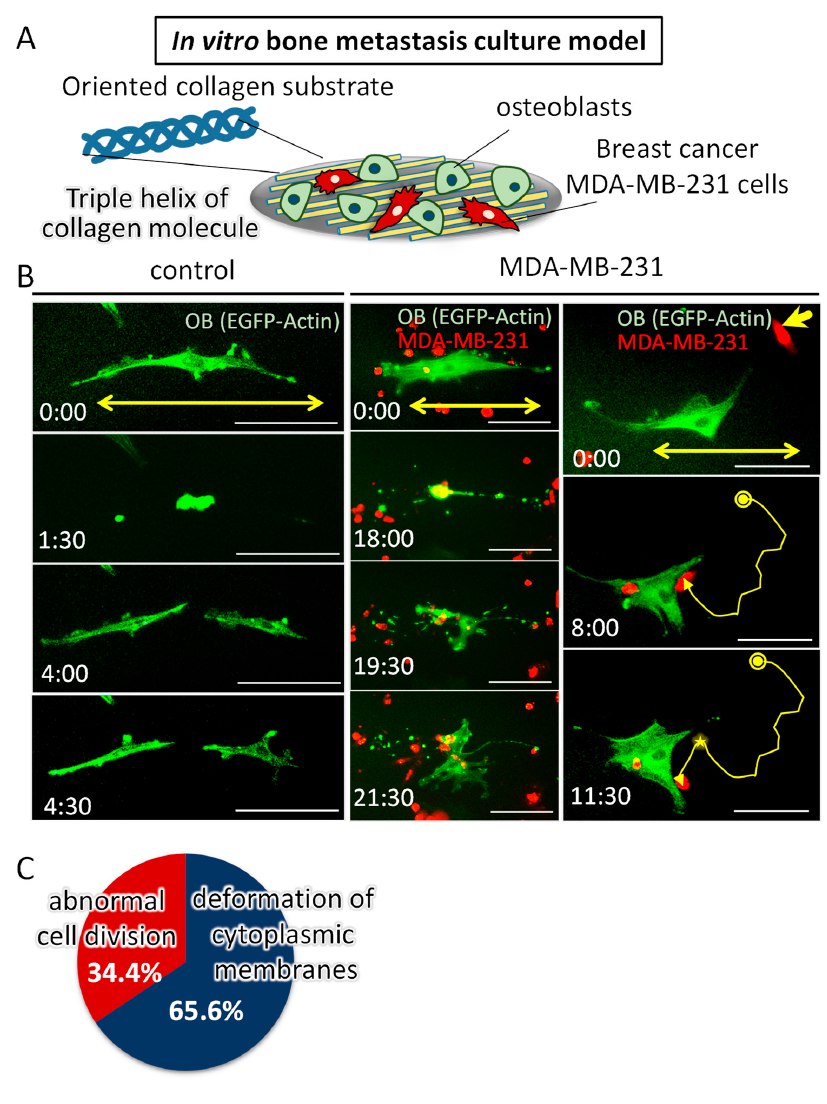
Figure 4. ( A ) Schematic illustration of the in vitro bone metastasis culture model. Osteoblasts and breast cancer MDA-MB-231 cells were cocultured on an artificially controlled oriented collagen substrate. ( B ) Time-lapse imaging of the monocultured osteoblasts (control), and cocultured osteoblasts and MDA-MB-231 cells. Green; EGFP-Actin (osteoblasts), Red; CellTracker (MDA-MB-231 cells). The yellow double-headed arrows indicate the substrate collagen orientation. The yellow arrows with yellow circles indicate the locomotion traces of MDA-MB-231 cells. The yellow circles indicate the initial position of the MDA-MB-231 cell represented by the bold yellow arrow. The star mark indicates the intercellular collision position. Scale bars: 100 µm. ( C ) Quantitative analysis of the frequency of the observed two types of dynamic collision behavior that lead to the disrupted alignment of osteoblasts.